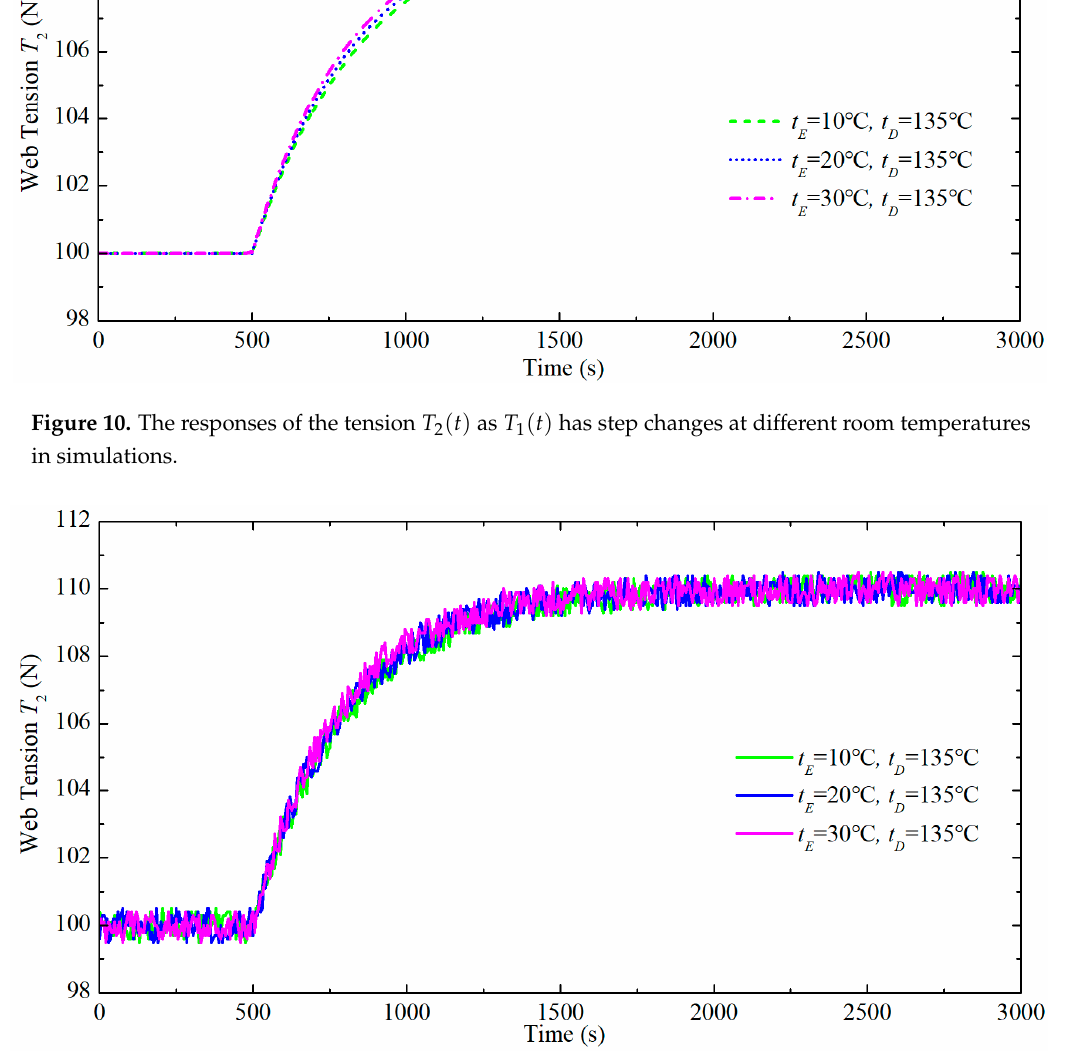
Figure 11. The responses of the tension T 2 ( t ) as T 1 ( t ) has step changes at different room temperatures in experiments.